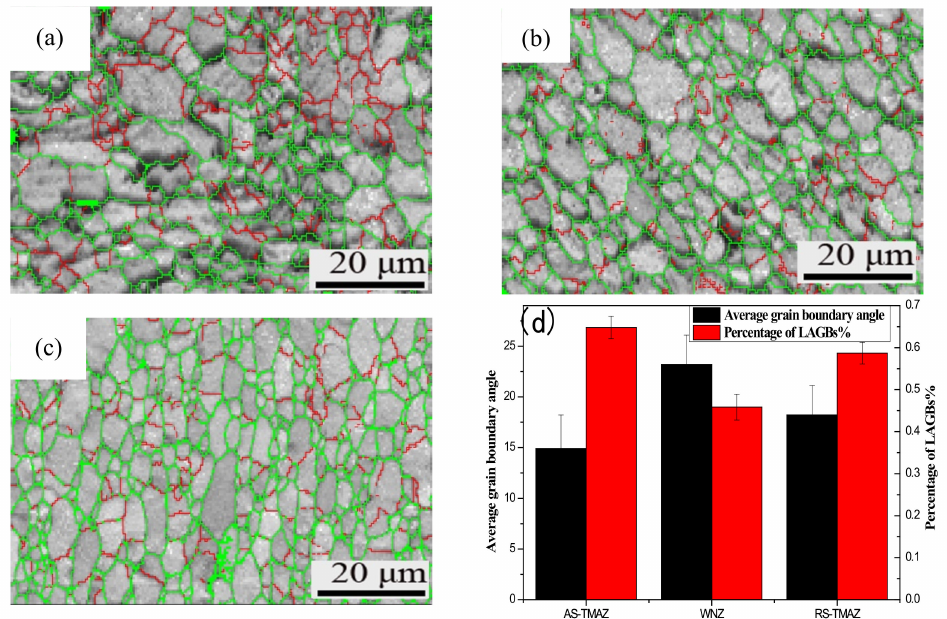
Figure 5. Grain boundary maps: ( a ) AS-HAZ; ( b ) SZ; ( c ) RS-TMAZ; ( d ) Value of grain boundaries of 7A52 aluminum alloy FSW